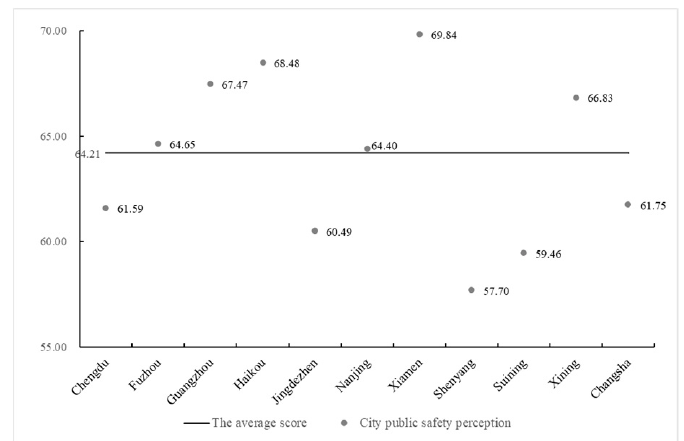
Figure 3. Evaluation of the floating population with higher education background (FPHEB)’s perception of urban public safety (PUPS) in different cities.